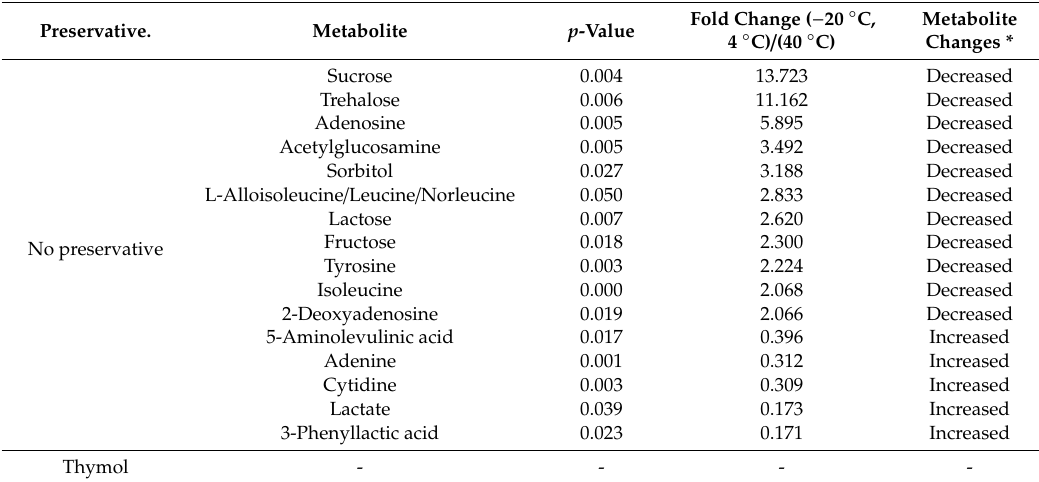
Figure 2. Volcano plots of low temperature (−20 °C, 4 °C/24 h, 4 °C/48 h) versus high temperature (40 °C/24 h, 40 °C/48 h) in the PABA group with ( A ) no preservative, ( B ) thymol and in the No PABA group with ( C ) no preservative, and ( D ) thymol. Red dots indicate metabolites with p -value < 0.05 and fold change (low temperature (−20 °C, 4 °C)/high temperature (40 °C)) > 2 or < 0.5. Table 3. Significantly altered metabolites caused by high temperature (40 °C) in urine samples with no preservative or preserved with thymol in the PABA group .